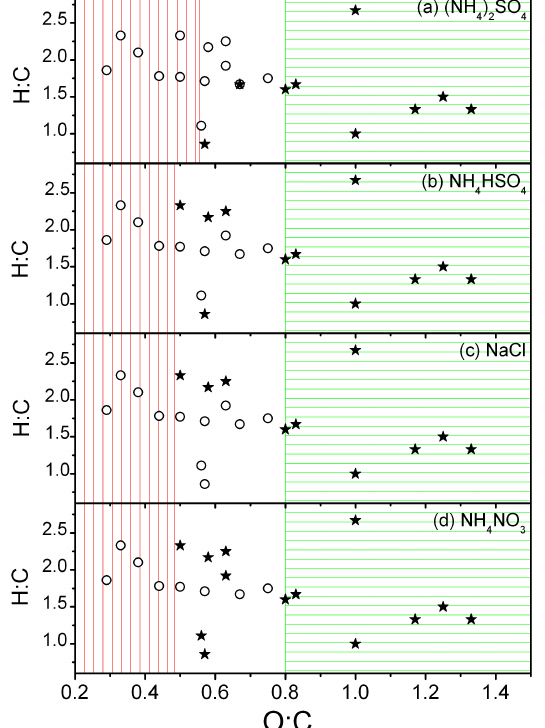
Fig. 2. Van Krevelen Diagram for the different mixed organic- inorganic salt particles (OIR = 2.0 ± 0.1) studied: (a) organic- ammonium sulfate particles, (b) organic-ammonium bisulfate par- ticles, (c) organic-sodium chloride particles and (d) organic- ammonium nitrate particles. Open circles indicate that liquid–liquid phase separation was observed, while stars indicate that liquid– liquid phase separation was not observed. The vertical hatched re- gions correspond to the H:C and O:C conditions when liquid– liquid phase separation was always observed and the horizontal hatched regions correspond to the H:C and O:C conditions when liquid–liquid phase separation was never observed.